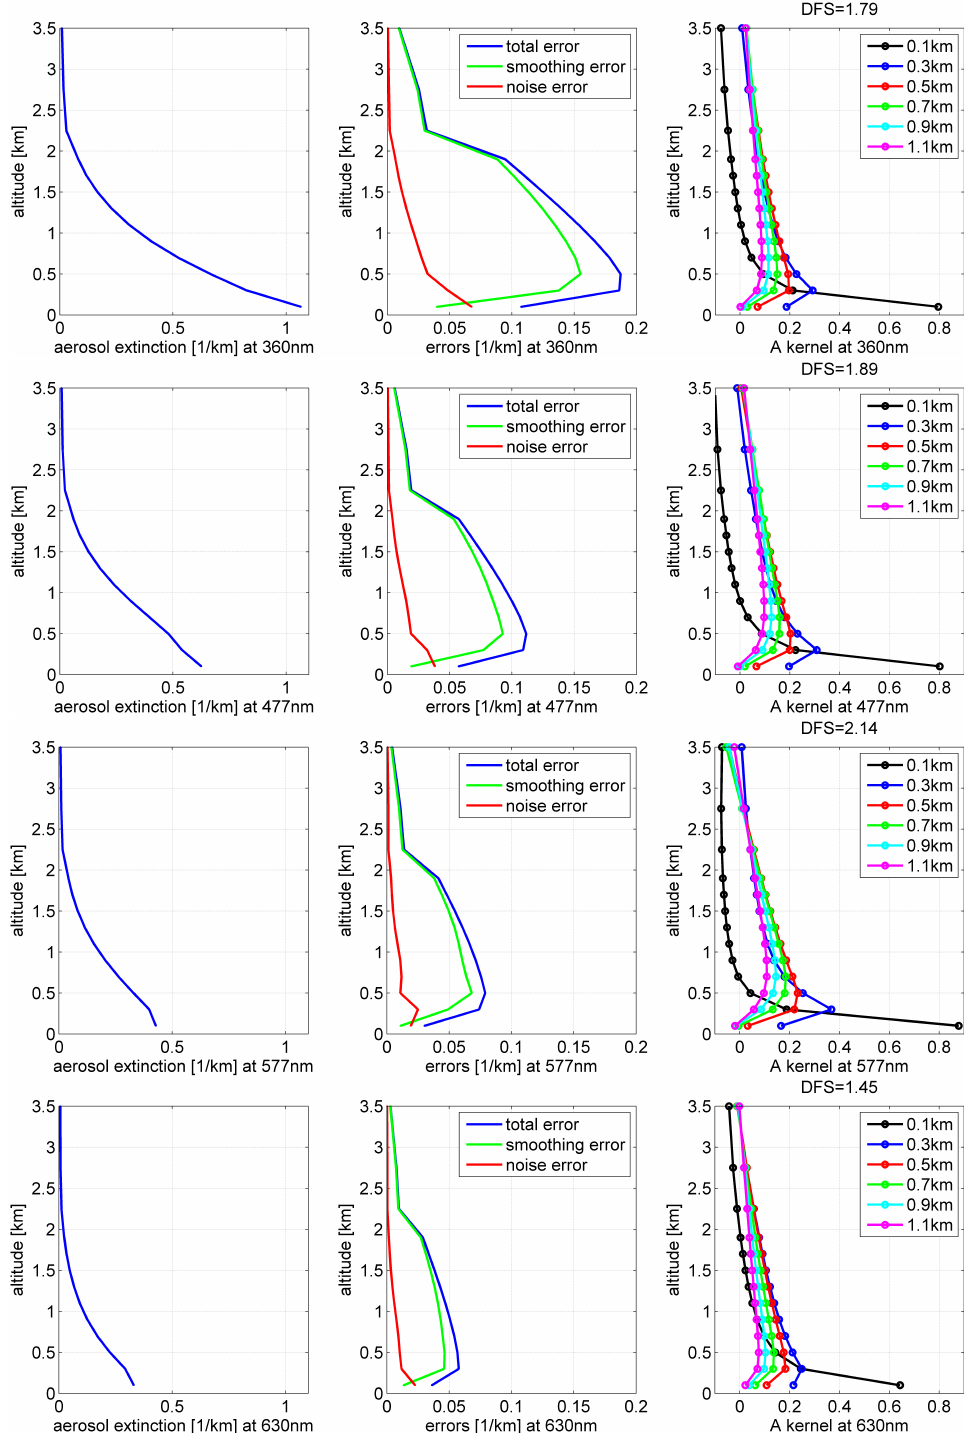
Fig. 11. Mean aerosol extinction profiles (left), error budget (middle), and averaging kernels (right) obtained at 4 wavelengths from the MAXDOAS measurements made in Beijing from June 2008 to April